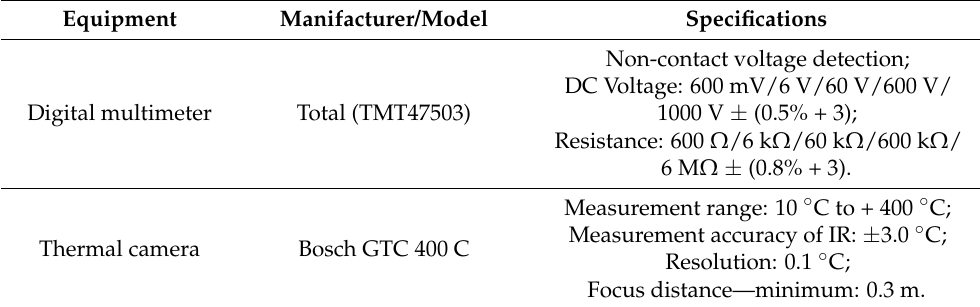
Figure 3. Electron microphotographs of WS-derived carbons: ( a – c ) SEM images before thermo- chemical activation; ( d – f ) SEM and ( g , h ) TEM images after thermo-chemical activation .